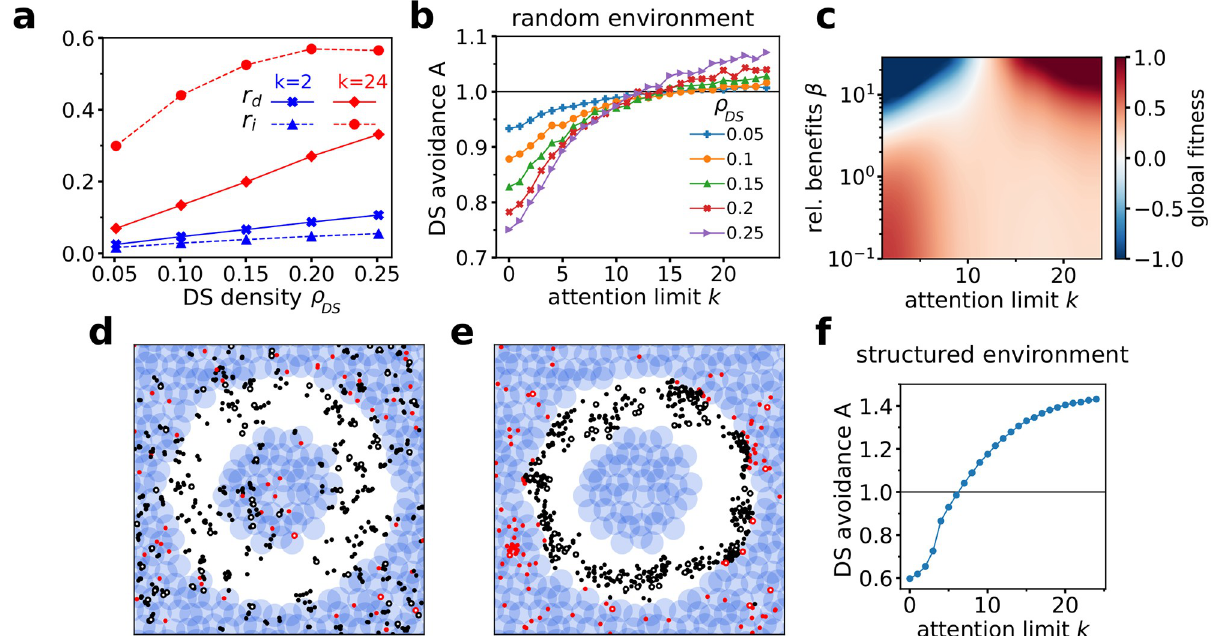
Fig 4. Collective response to environmental cues. a : The fraction of agents responding to DS directly r d (direct responders, solid lines), or indirectly via social interactions with direct responders r (indirect responders, dashed lines), for k = 2 (blue) and k = 24 (red) versus DS density ρ . b : DS i DS avoidance A versus attention limit k for different DS densities ρ . A = 1 corresponds to the DS avoidance of solitary (non-interacting) agents. c : Global DS fitness versus attention limit k and relative benefits of DS avoidance β at ρ DS = 0.25. Red (blue) regions correspond to better (worse) performance of a collective than isolated individuals according to the fitness function used. d and e : Example snapshots of emergent collective behavior in structured environments with a circular, DS-free path. For low attention capacity ( k = 1, e ), individuals ignore the structure of the environment and align with the preferred direction of migration. At high attention capacity ( k = 16, f ), the collective behavior is dominated by the environmental structure and collective migration breaks down. f : DS avoidance A for the structured environment depicted in d , e versus attention limit k . A = 1 is the DS avoidance of solitary agents in the same environment. For all panels: R = inf